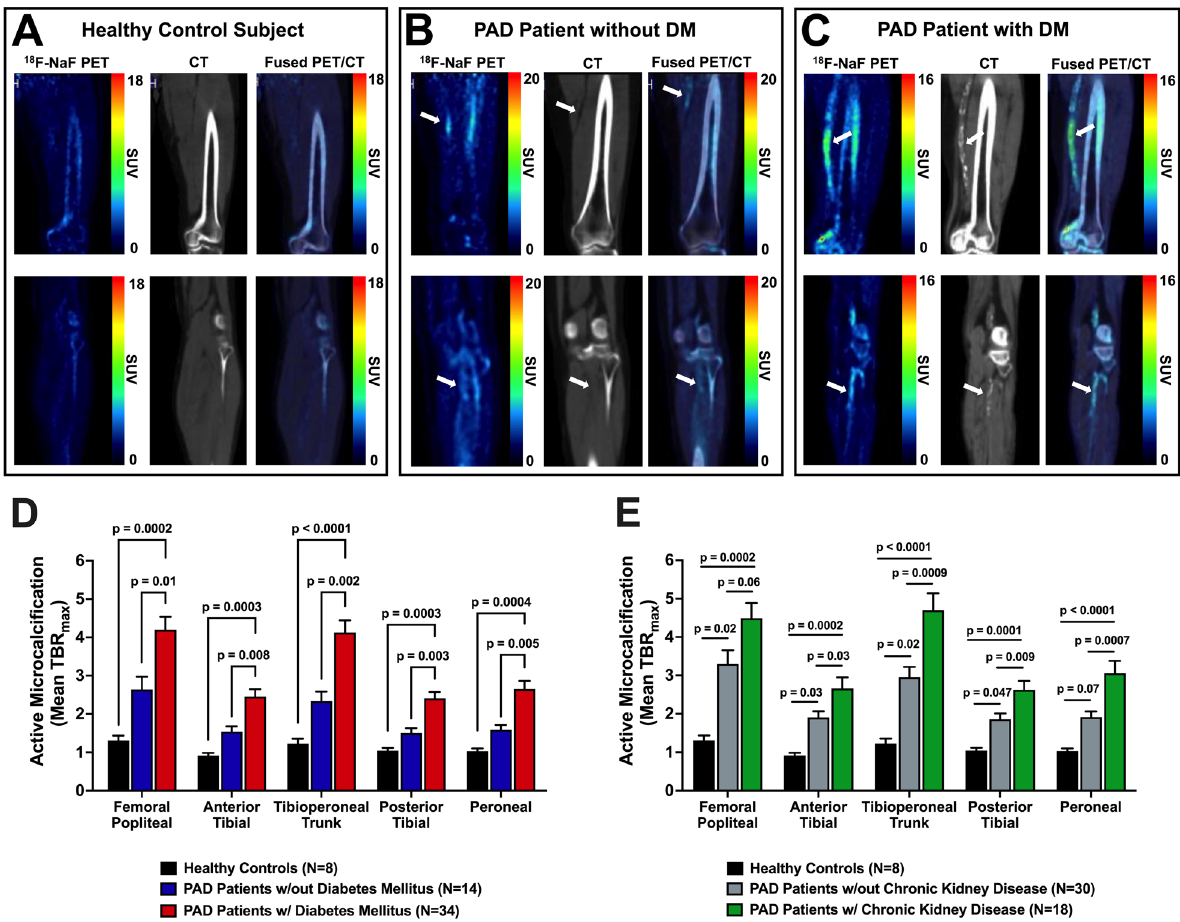
Fig. 3 Qualitative and quantitative analyses of lower extremity 18 F‑NaF PET/CT imaging in healthy control subjects and patients with PAD. Representative 18 F‑NaF PET/CT images of a A healthy control subject, B PAD patient without DM, and C PAD patient with DM, which reveal increasing arterial uptake of 18 F‑NaF and established calcium burden with worsening disease status. Quantitative vessel‑by‑vessel PET/CT image analysis demonstrates D DM‑ and E CKD‑induced differences in arterial uptake of 18 F‑NaF between patient groups for each lower extremity artery of interest. White arrows denote regions of focal uptake of 18 F‑NaF in patients with PAD. Values represent means ±